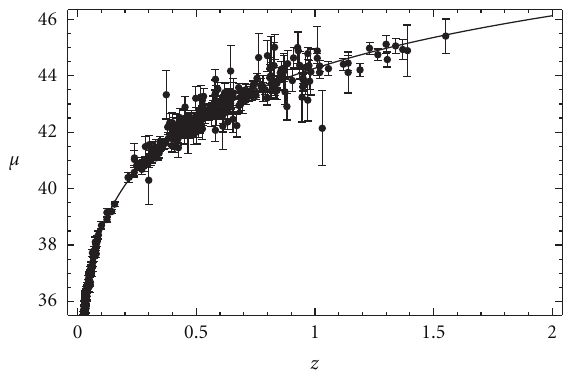
Figure 1: Relation between distance modulus and redshift. The solid line corresponds to the theoretical value calculated from the model concerned. The dots with error bar are the data from the 397 Constitution